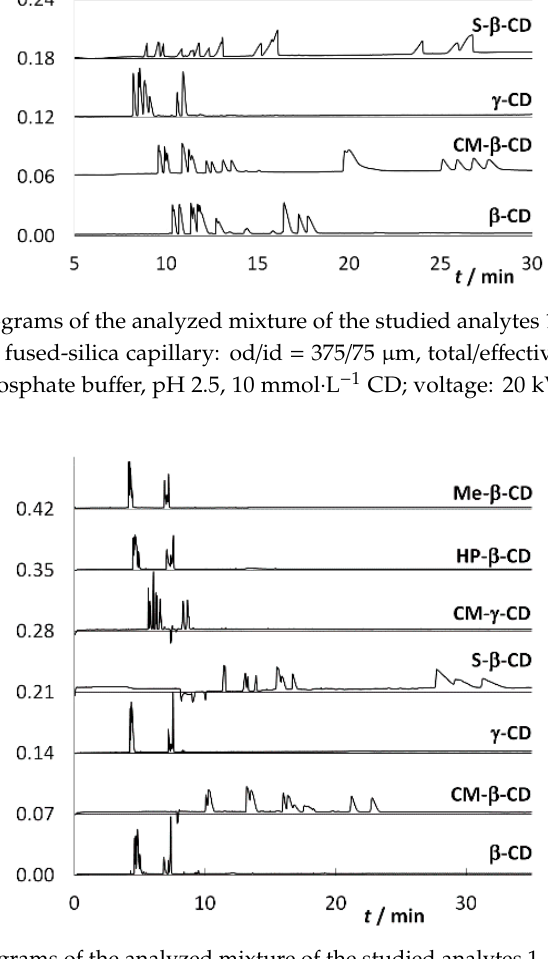
Figure 4. Electropherograms of the analyzed mixture of the studied analytes 1–9 (Figure 2) obtained at di ff erent CDs used; fused-silica capillary: od / id = 375 / 75 µ m, total / e ff ective length: 58.5 / 50.0 cm; BGE: 50 mmol · L − 1 acetate bu ff er, pH 5, 10 mmol · L − 1 CD; voltage: 20 kV; temperature: 25 ◦